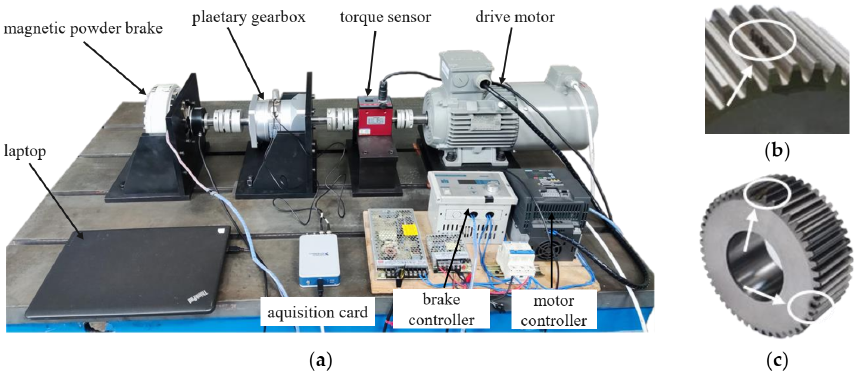
Figure 7. ( a ) Experimental test rig, ( b ) pitting planet gear, and ( c ) spalling and root crack planet